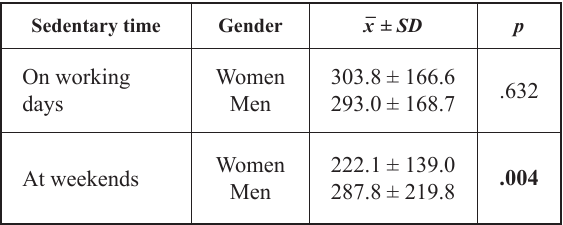
Table 3. Sedentary time (min/day) spent on working days and at weekends by gender Sedentary